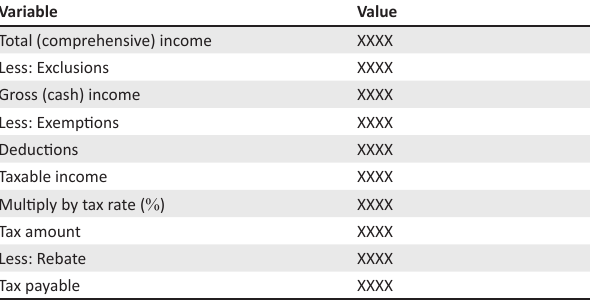
TABLE 2: 2005/2006 and 2010/2011 personal income tax brackets. TABLE 1: Calculation of personal income tax liability.